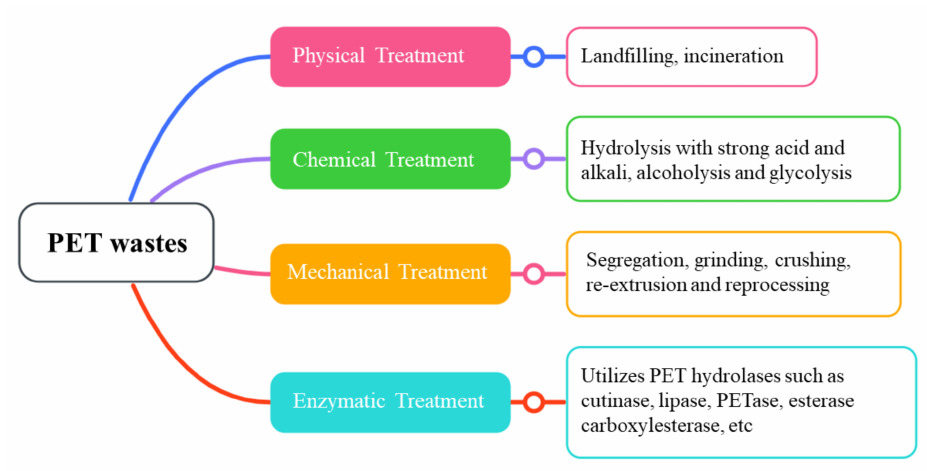
Figure 1. Recycling treatments to treat PET